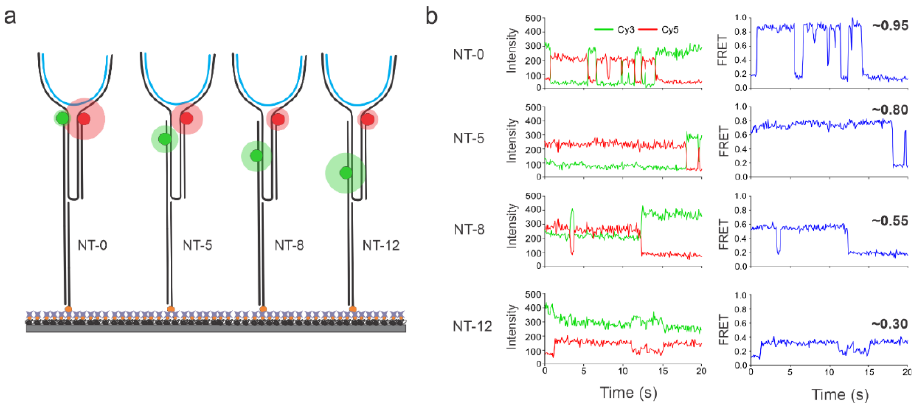
Figure 5. ( a ) Schematic representation of the proof-of-concept multiplexing experiment. The four NT sensors with different inter-dye distances used here were all designed to detect DNA-92a. The red and green spheres represent Cy5 and Cy3 fluorophores respectively and the blue lines represent DNA-92a. ( b ) Typical intensity-time traces from the multiplexed data with varying E FRET values. The NT sensors were post-assigned after analyzing each trace’s high-FRET state and comparing it with the observed high-FRET states of each individual NT sensor.